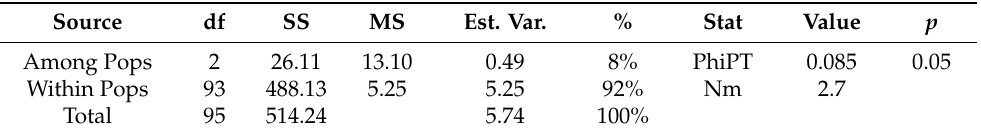
Table 4. Analyses of molecular variance (AMOVA) based on six SSR loci and estimates of gene migration (Nm) among and within three D. rabiei populations.